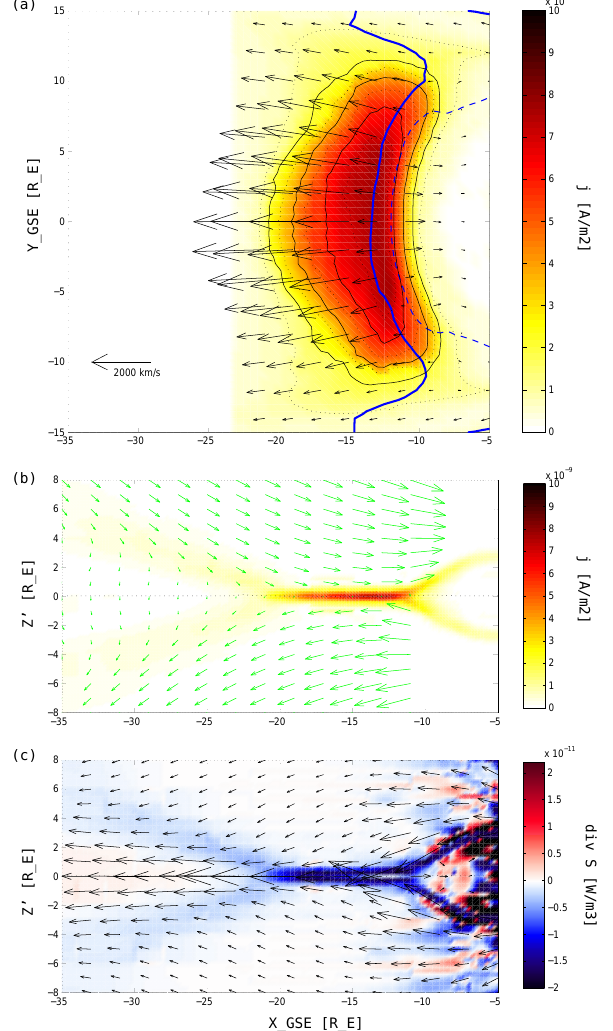
Fig. 5. The reconnection region at 04:35, when the reconnection rate peaks, in the same run as in Fig. 4. (a) The current sheet from above. Colouring and black contour lines depict current density, and arrows are plasma flow velocity vectors. The thick solid blue line is the magnetic x-line and the dashed blue line is the flow reversal line. (b) The perpendicular plane. Colouring is current density and arrows are magnetic field vectors on the plane. (c) The perpendicu- lar plane again. Now the colouring is the divergence of the Poyntig vector, ∇· S , and the arrows are plasma flow velocity vectors. The narrow whitish stripe within the dark blue reconnection region is a numerical feature having no physical relevance.